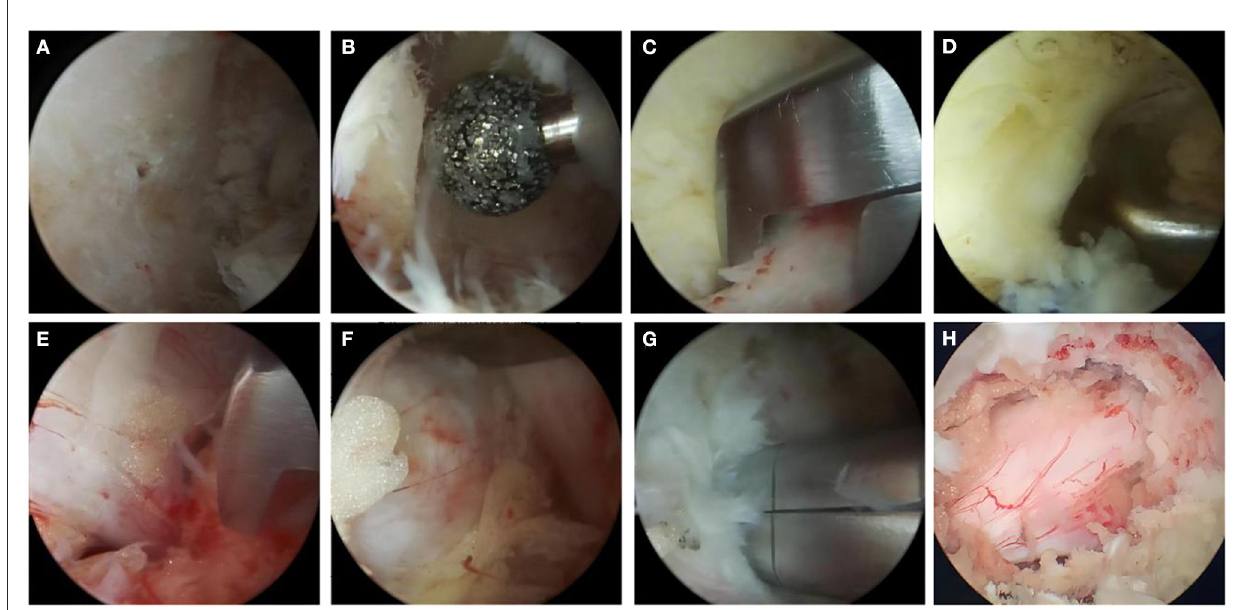
FIGURE1 The operation process of UBE-ULBD technique: (A) Plasma cutter separates soft tissue on the surface of bony lamina and ligamentum flavum to establish endoscopic workspace. (B–D) Using pliers bite or grinding drill to remove the upper and lower edge of the lamina bone, exposing the starting and ending points of the ligamentum flavum. (E) The gun pliers completely bite off the ligamentum flavum. (F, G) exposing and removing intervertebral disc, plasma knife head for annulus fibrosus formation. (H) Relaxed dural and nerve roots after full decompression. One typical cases with Single level severe DLSS received